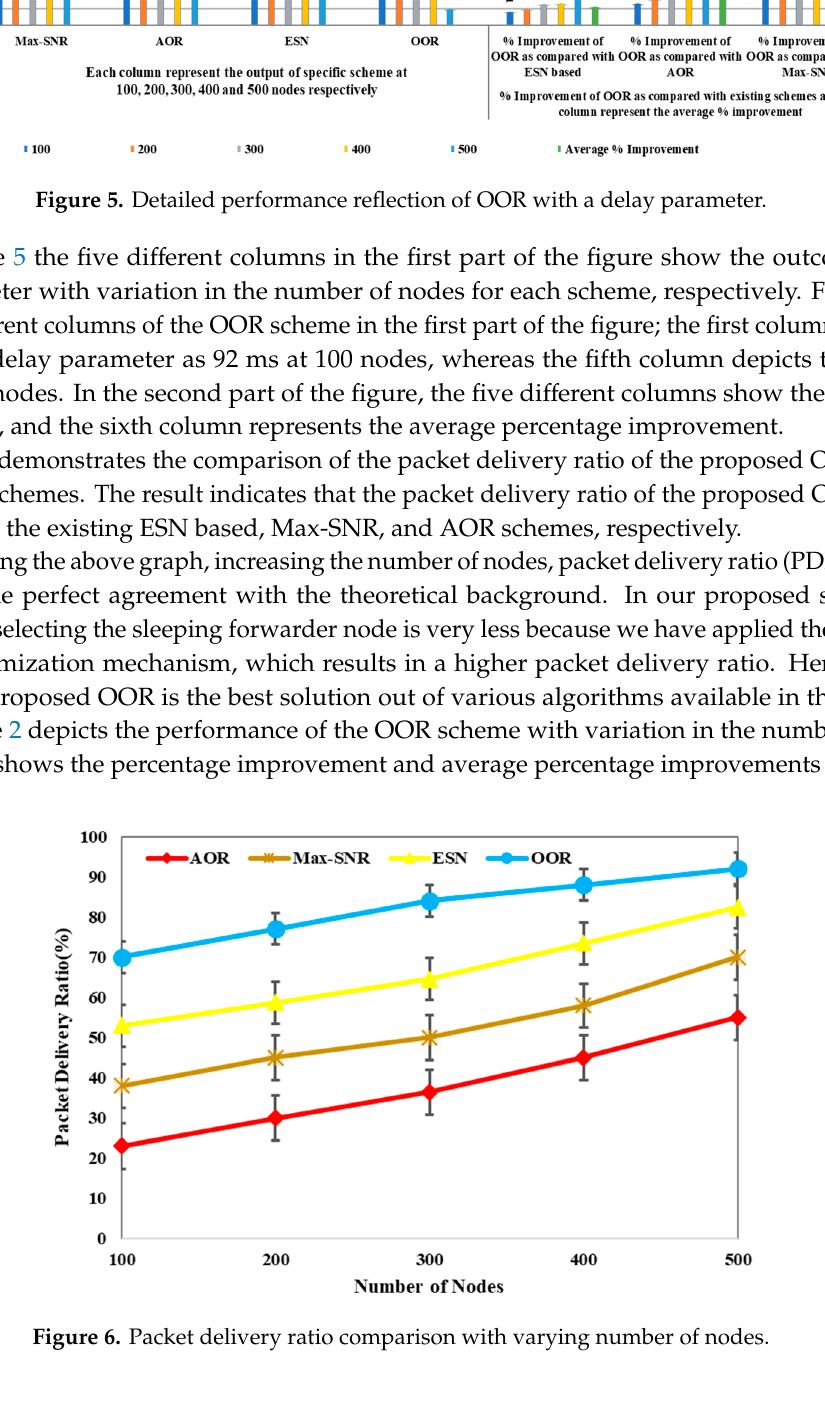
Figure 6. Packet delivery ratio comparison with varying number of nodes.